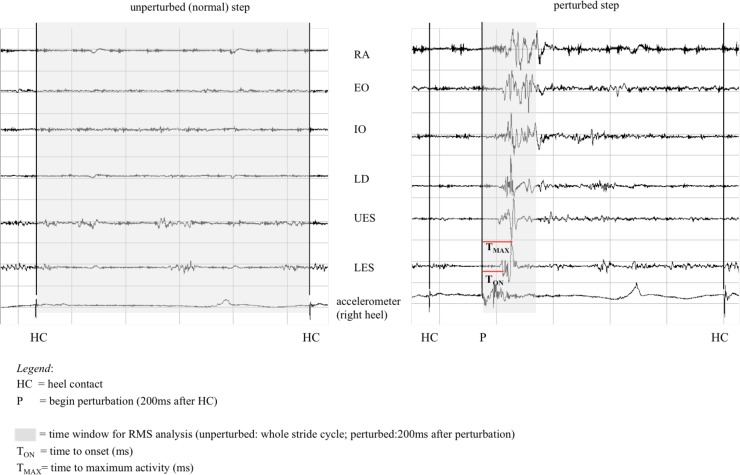
Exemplarily EMG signal for the 6 right-sided trunk muscles (raw signal of 1 perturbation for one subject) including visualization of EMG outcome measures (EMG-RMS, TON, TMAX).